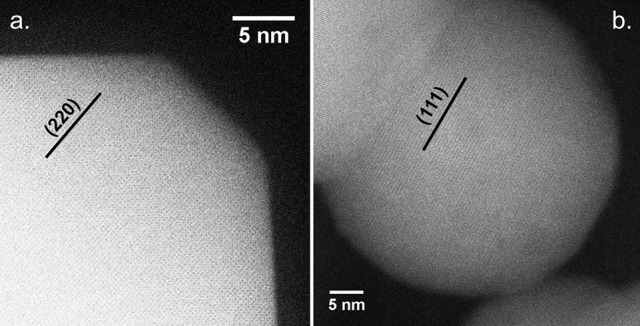
HRTEM images of Co3O4 originating from (a) faceted h-CoO and (b) f-CoO.